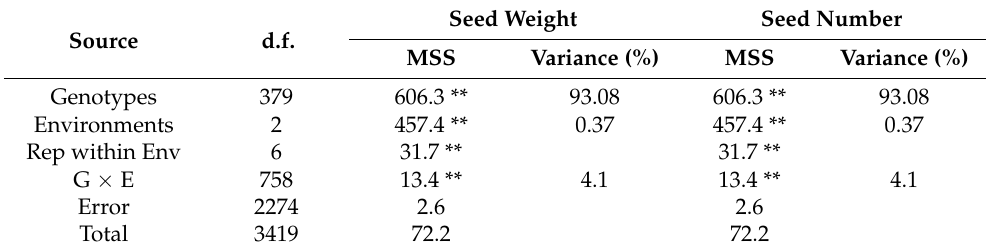
Table 2. Pooled ANOVA for seed weight and seed number across the